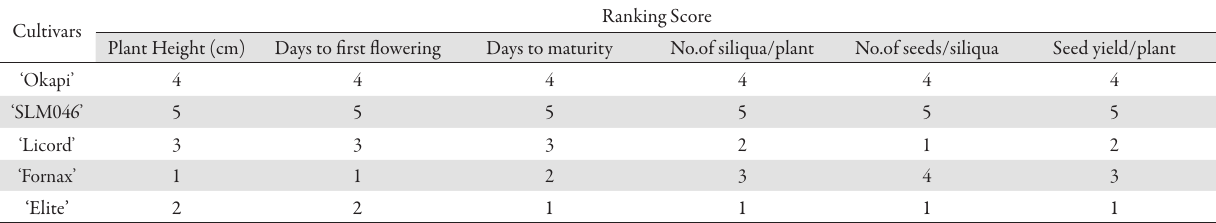
Tab. 2. Ranking score of different varieties against different levels of salinity on the basis of regression coefficient values